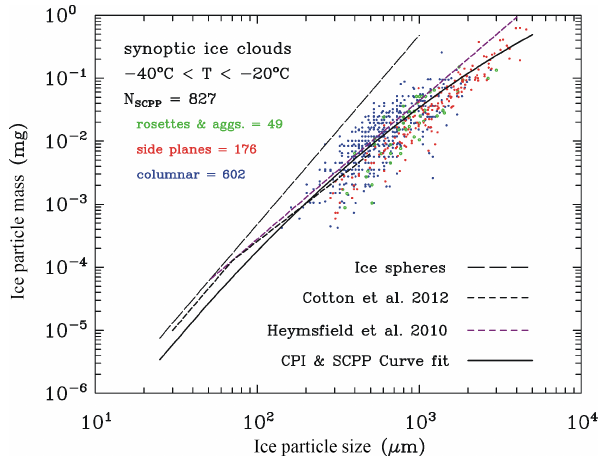
Figure 9. Same as Fig. 8, except the m - D curve fit is based on SPARTICUS (2D-S and CPI) data and the SCPP field data have been grouped into size bins; shown are the standard deviations ( σ) in m and D for each size bin. Mean values for m and D are shown by the intersection of the σ - bars